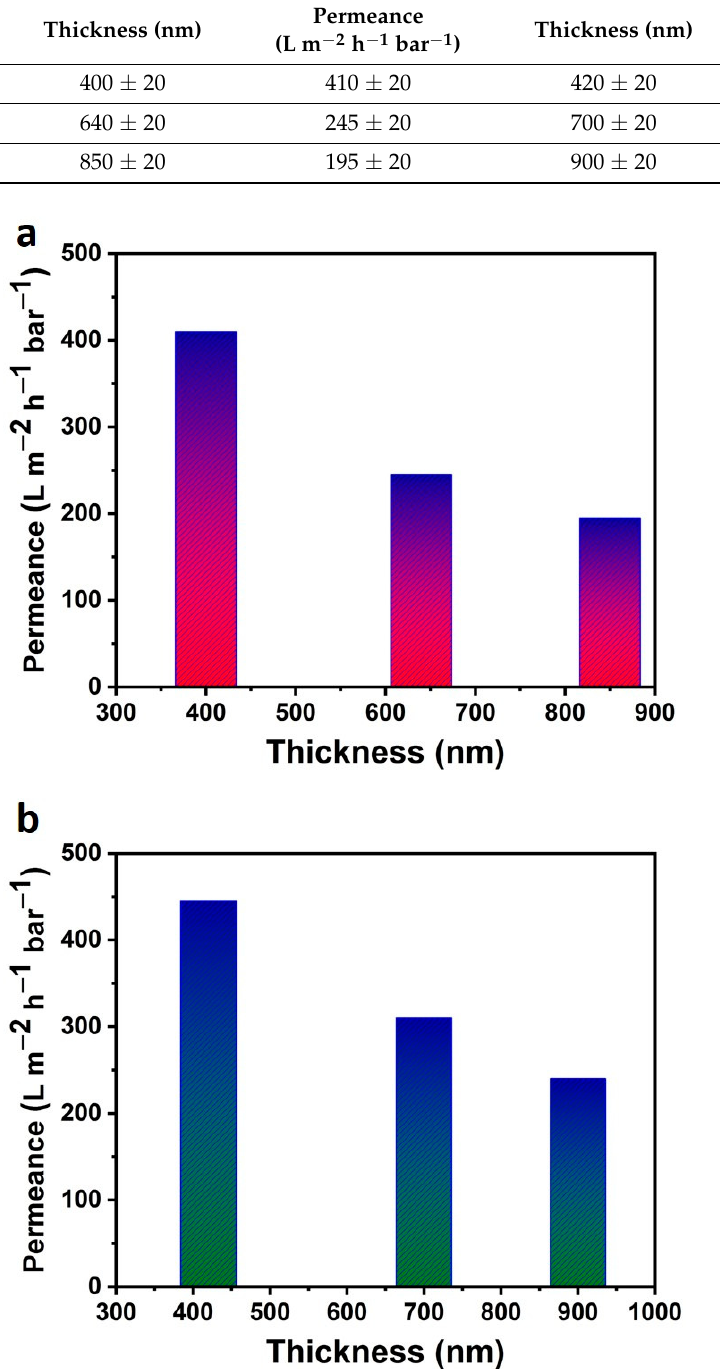
Figure 3. ( a , b ) Water permeance of MoO 2 @GO ( a ) and WO 3 @GO ( b ) nanocomposite membranes at variable thicknesses.